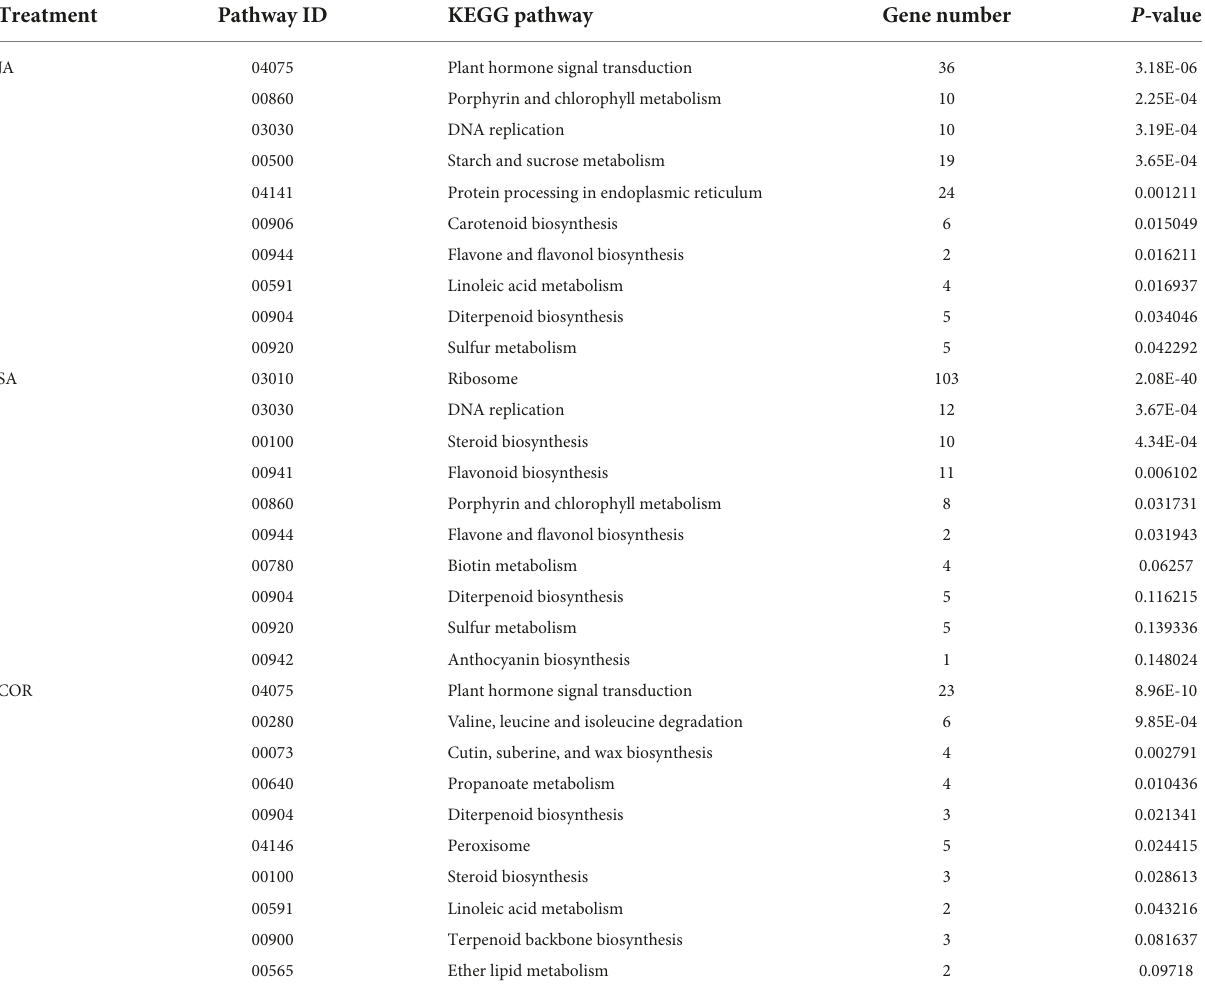
TABLE 4 The Kyoto encyclopedia of genes and genomes (KEGG) pathways (top 10) enriched by down-regulated differentially expressed genes (DEGs) under the three treatments.